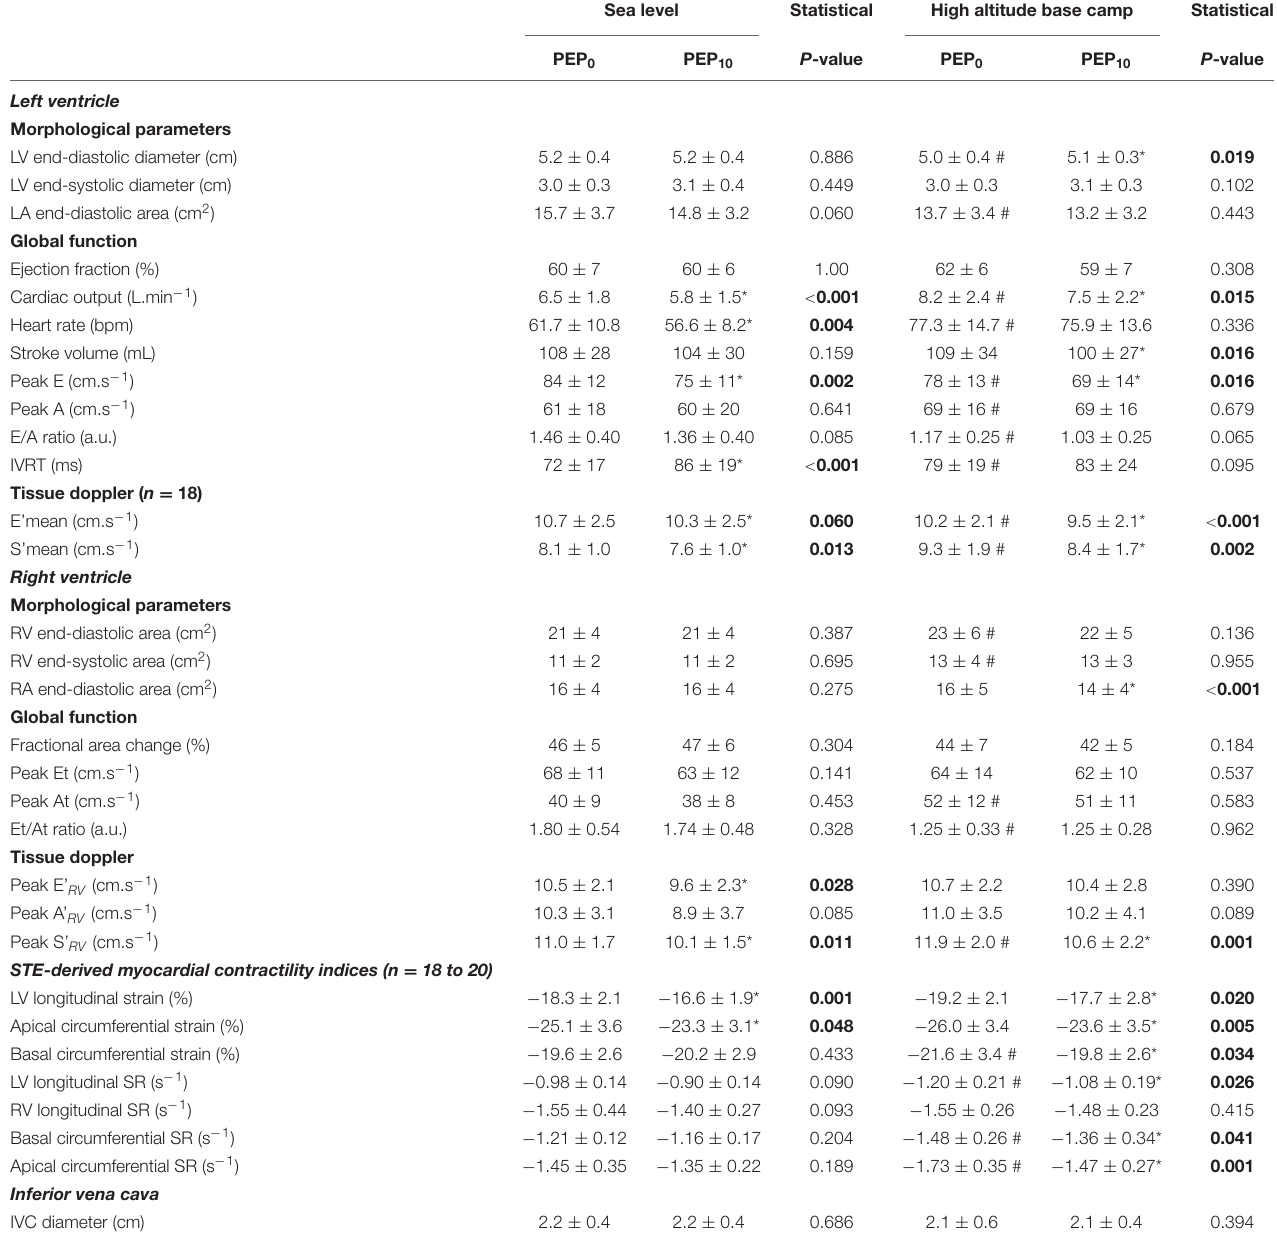
TABLE 2 | Morphological and functional cardiac parameters while breathing with PEP 0 and PEP 10 at sea level and at high altitude base